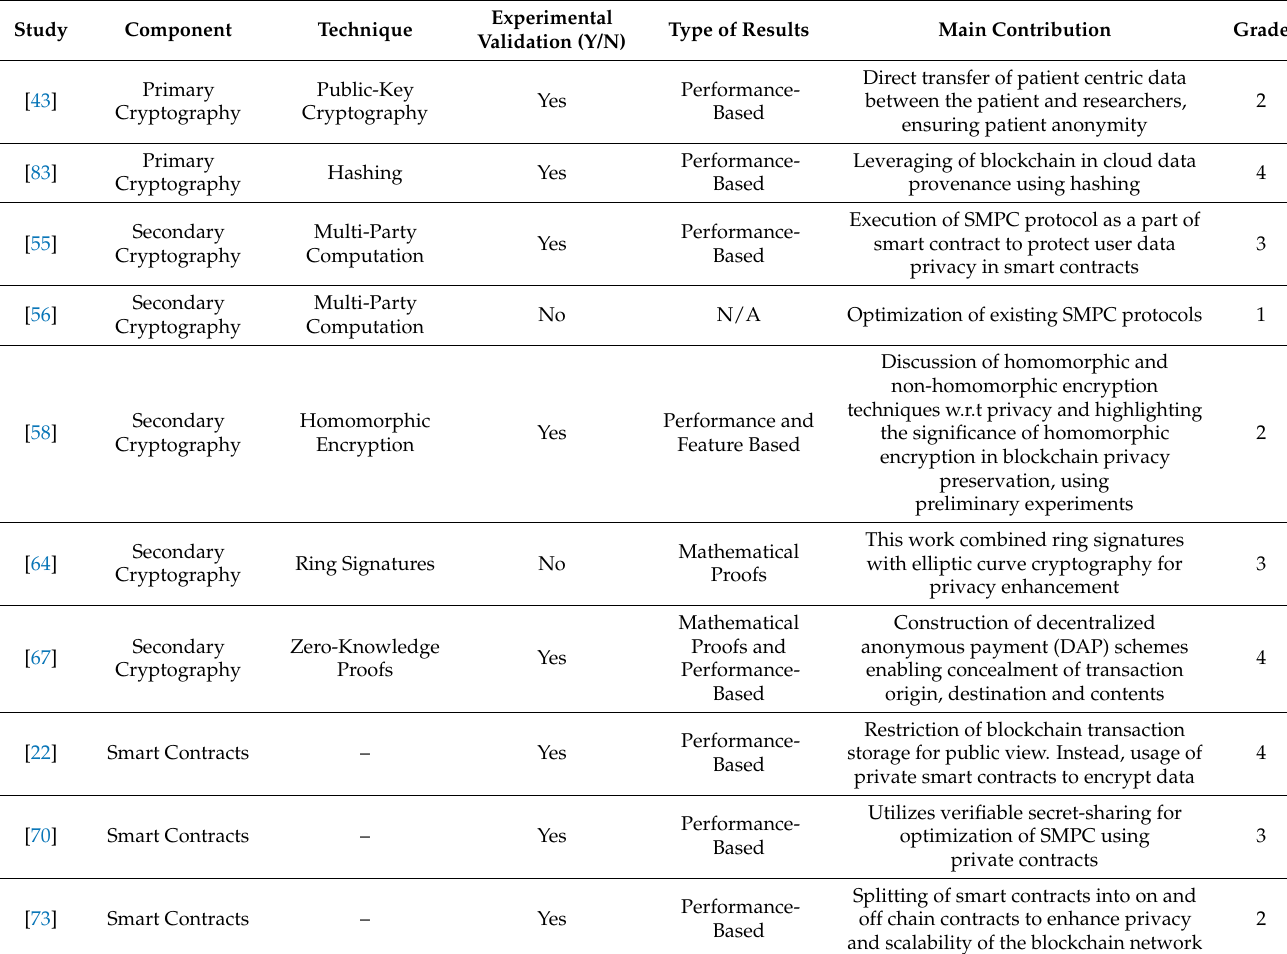
Table 2. Comparative analysis of privacy preserving